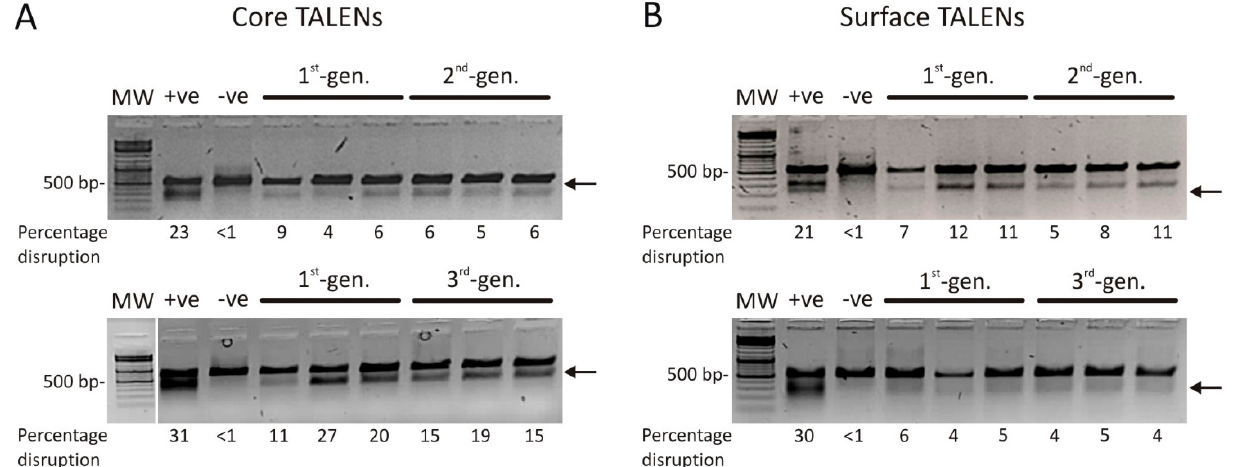
Figure 2. Targeted cleavage of viral DNA in cultured cells. Analysis of targeted mutation sequences targeted by second- ( A ) and third- ( B ) generation TALENs employing the Surveyor assay. Arrows depict cleaved heteroduplexes. MW: molecular weight marker, +ve: HBx heteroduplexes, − ve: mock transfection.